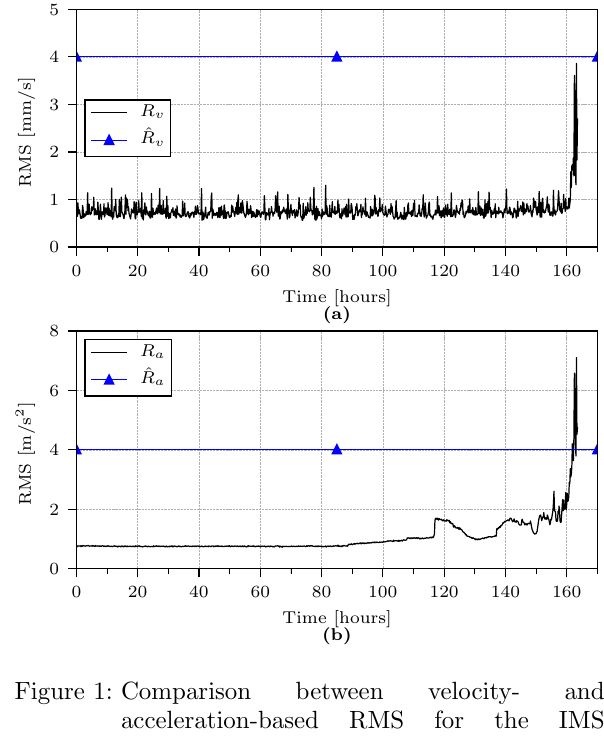
Figure 1: Comparison between velocity- and acceleration-based RMS for the IMS dataset. (a) velocity-based RMS and its FT; (b) acceleration-based RMS and its